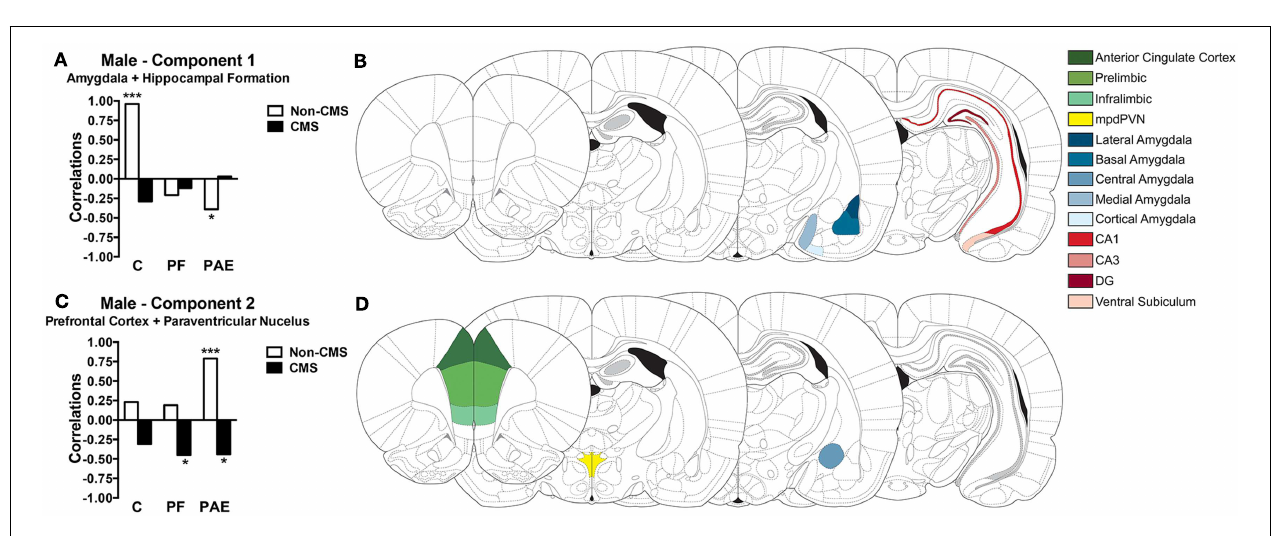
areas that contributes to each neural network (B,D) . Images were adapted from Ref. (46), *** p < 0.0001; * p < 0.05. C, control; PF, pair-fed; and PAE, prenatal alcohol exposed.